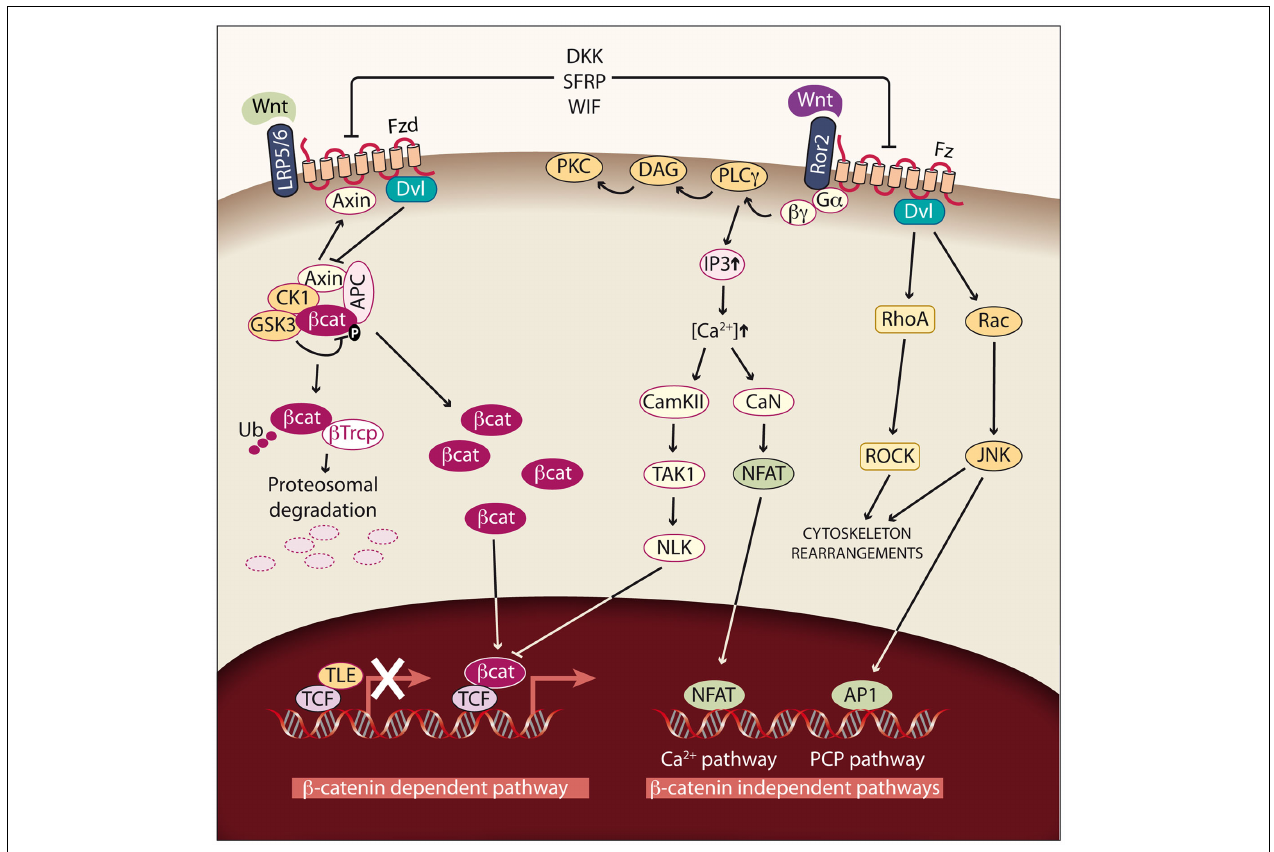
Non-canonical or β -catenin-independent pathways. Binding of the non-canonicalWnt factorsWnt4,Wnt11, orWnt5A to different Fzd receptors and the Ror2 coreceptor transduce signaling by two different pathways.The Ca 2 + pathway promotes the activation of protein kinase C (PKC) via G-PLC γ and modulates cell adhesion and motility by activating calcium–calmodulin kinase (CamKII), and the phosphatase calcineurin (CaN).The planar